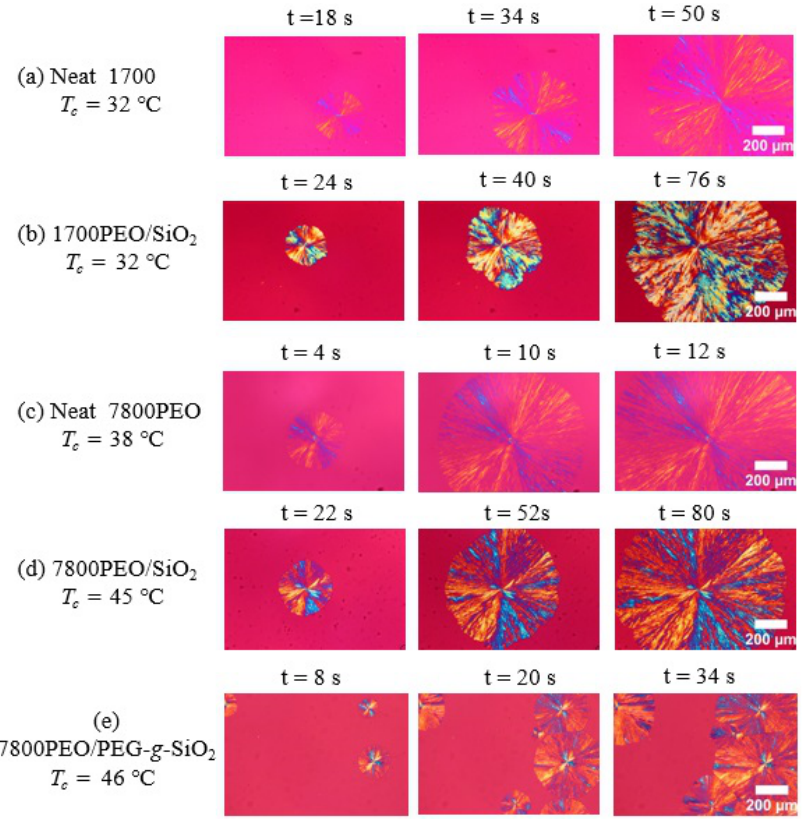
Figure A3. The equilibrium melting temperature of the PEO PNCs: ( a ) matrix M n = 1700 g/mol, ( b ) matrix M n = 7800 g/mol.